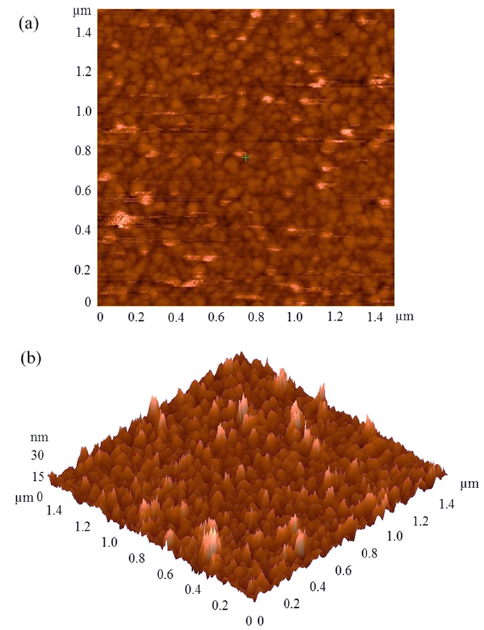
Figure 2. ( a ) Two- and ( b ) three-dimensional AFM images of the electrode fabricated by thermal evaporation